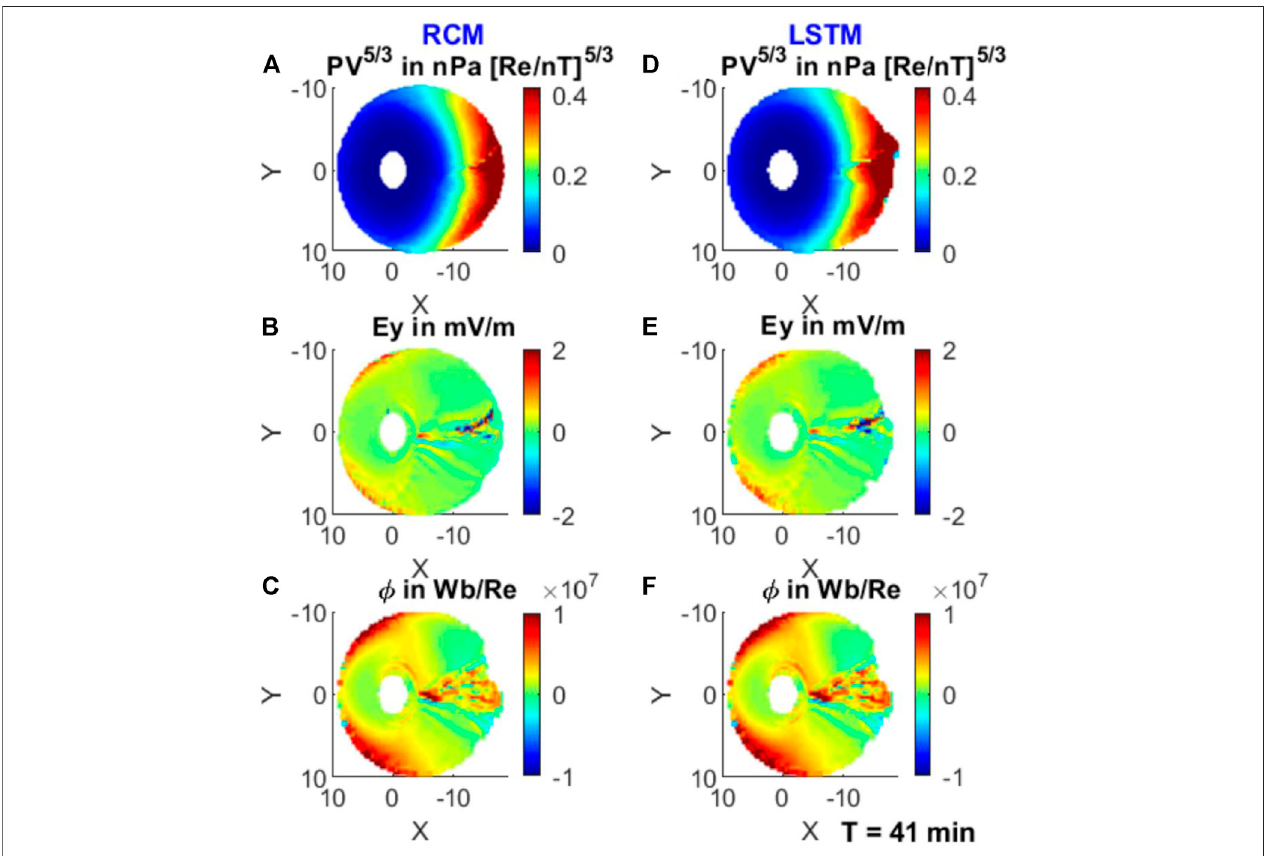
FIGURE 6 | Similar to Figure 5 , but for T (cid:1) 41